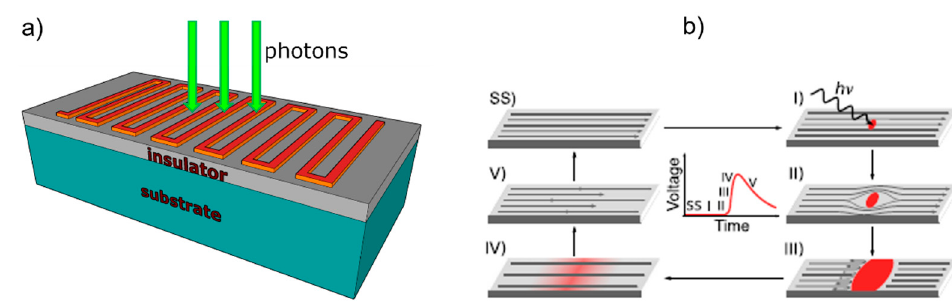
Figure 2. ( a ) A typical SNSPD structure sketch; ( b ) detection mechanism of an SNSPD reproduced from [39] with the permission of AIP Publishing. Photon absorption (I) generates quasi-particles and phonons (II), with the consequent breakdown of superconductivity (III). The resistivity returns to zero spontaneously (IV), and the charge passage due to the bias current is restored within the reset time (V). Center: voltage readout signal. SS: steady state of the SNSPD. Reproduced with permission of AIP Publishing from [39], copyright 2021.